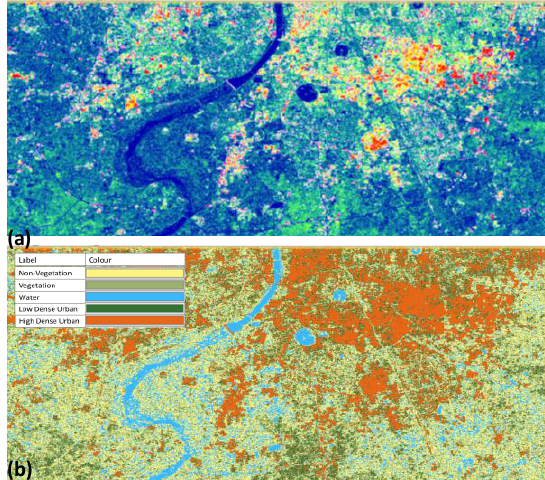
Figure 5. (a) FCC of PCs derived from GLCM textures and (b) Classified map of (a) Unsupervised classification is performed on 5(a) and the